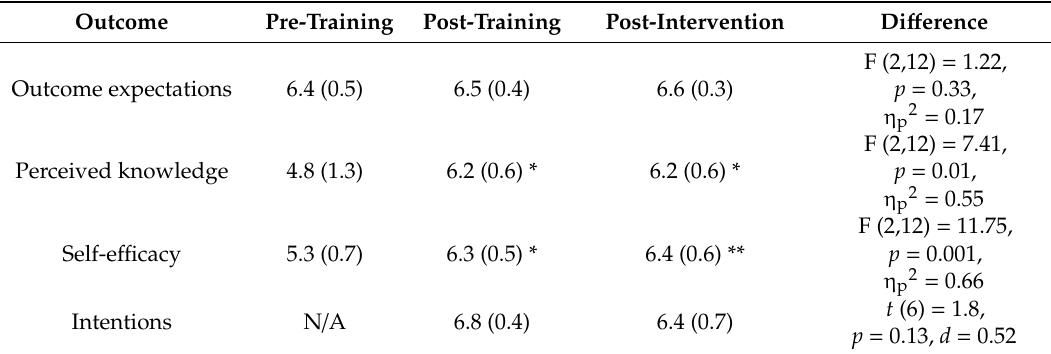
Table 2. Change in program leaders’ outcomes across time.